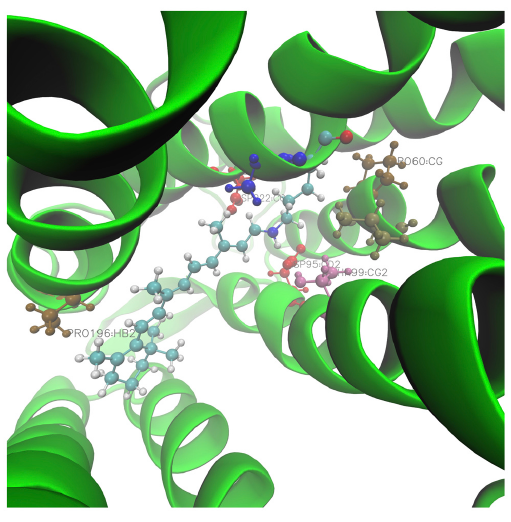
Figure 4. The visualization of residues, which were replaced in the site-directed mutagenesis study of archaerhodopsin-3 5 .